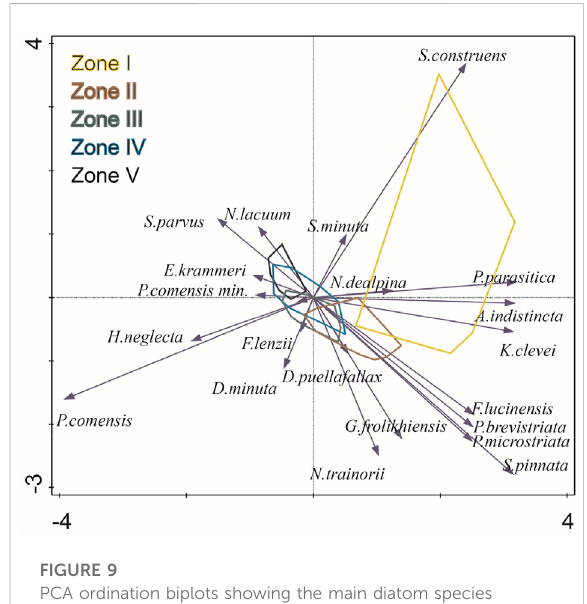
FIGURE 9 PCA ordination biplots showing the main diatom species (arrows) and samples from the sediment core KL 13 – 4 grouped into enveloped corresponding to the stratigraphical zones de fi ned by CONISS cluster